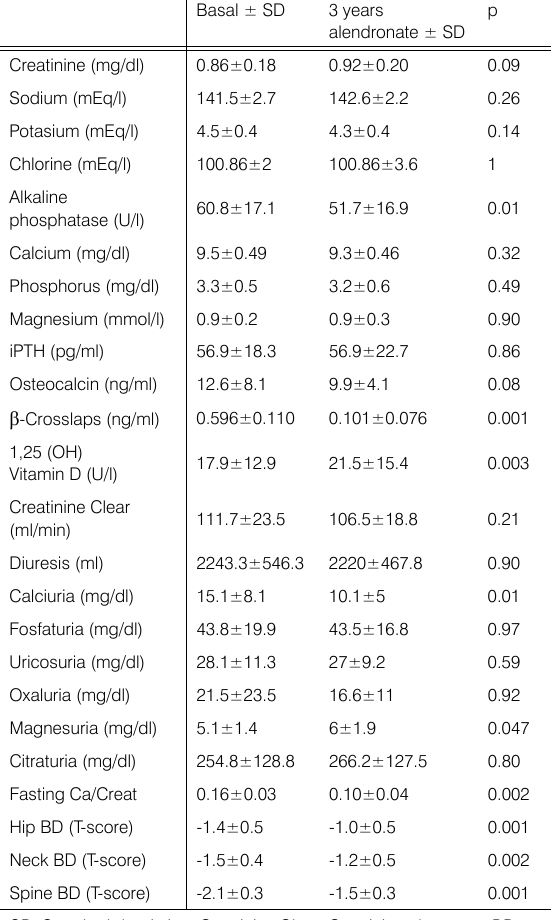
Table 2 . Evolution of the main parameters studied after 3 years of treatment with (Figure 2), and in fasting calcium/creatinine quotient (0.16 vs. 0.10 at three years; p=0.002) (Figure 3) (Table 2).